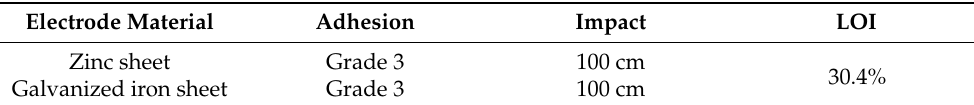
Figure 6. Growth curves of RP 10 wt.% and ATH 20 wt.%. Table 3. Performance test of the RP 10 wt.% and ATH 20 wt.% mixed system.